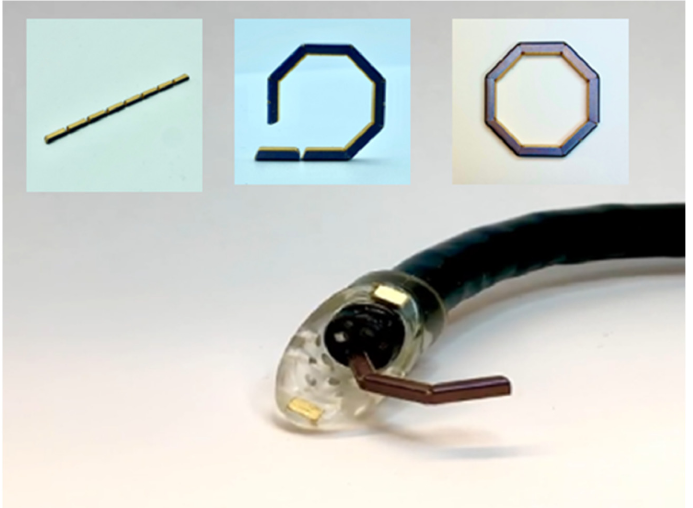
Figure 1. GI Windows Surgical TM self-forming magnetic rings that can be delivered through an endoscope into the target segments of the bowel. Magnetics rings auto-align and mate—leading to the formation of a magnetic compression anastomosis. (Permission for use granted by GI Windows Surgical, West Bridgewater, MA, USA.)